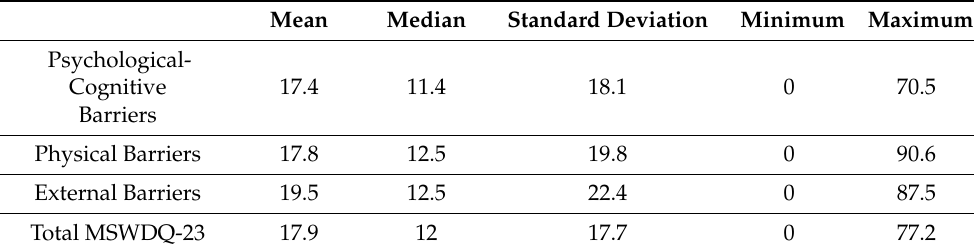
Table 3. Descriptive statistics of the MSWQ-23 subscales and total score.